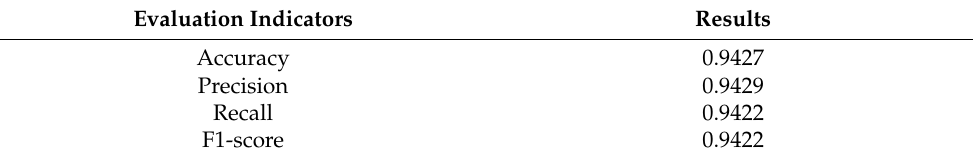
Table 7. CNN-based classifier’s test result of evaluation indicators for music genre classification.